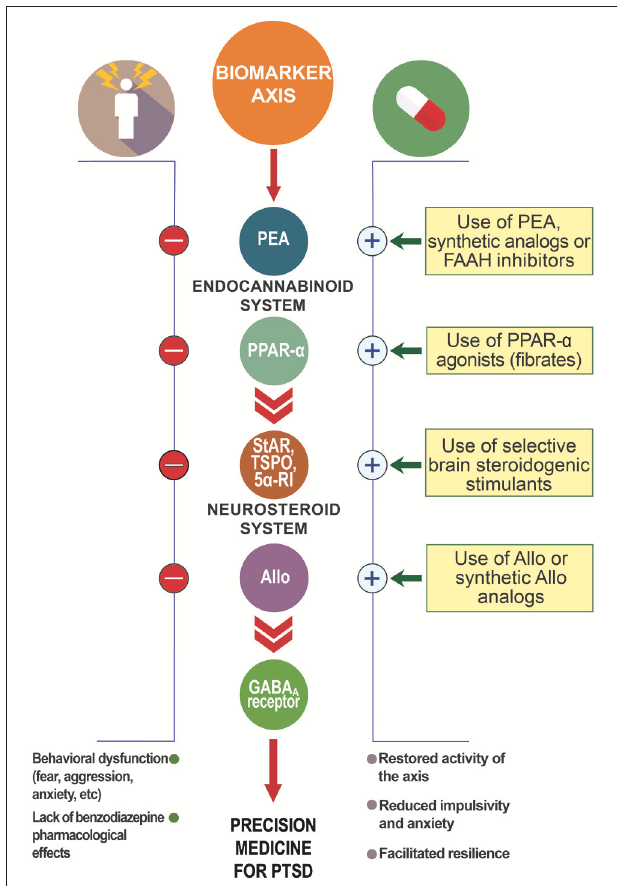
FIGURE 2 | Biomarker axis at the interface of the endocannabinoid and neurosteroid systems. In animal models of PTSD, protracted stress results in the downregulation of allopregnanolone biosynthetic enzymes (e.g., 5 α -reductase type I, 5 α -RI) and allopregnanolone concentrations